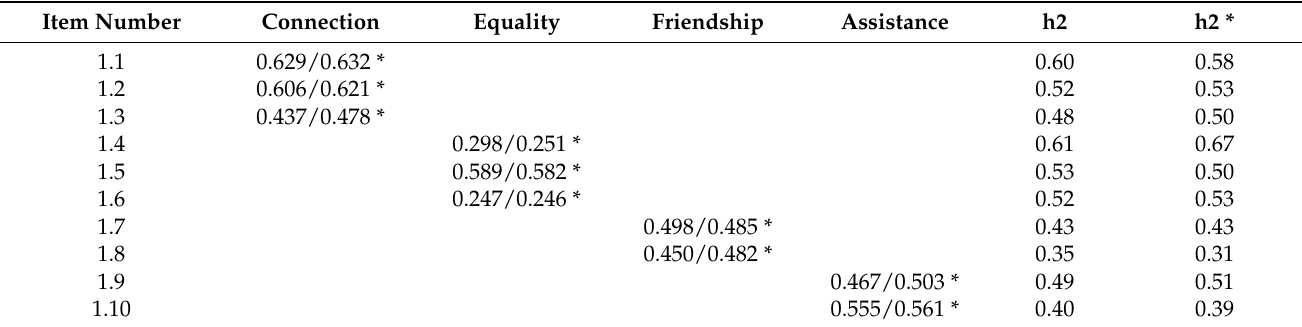
Table 2. Standardized item loadings for Confirmatory Factor Analyses the four factors relating to sports inclusion and item communalities for athletes with ID and for both athletes and partners *.